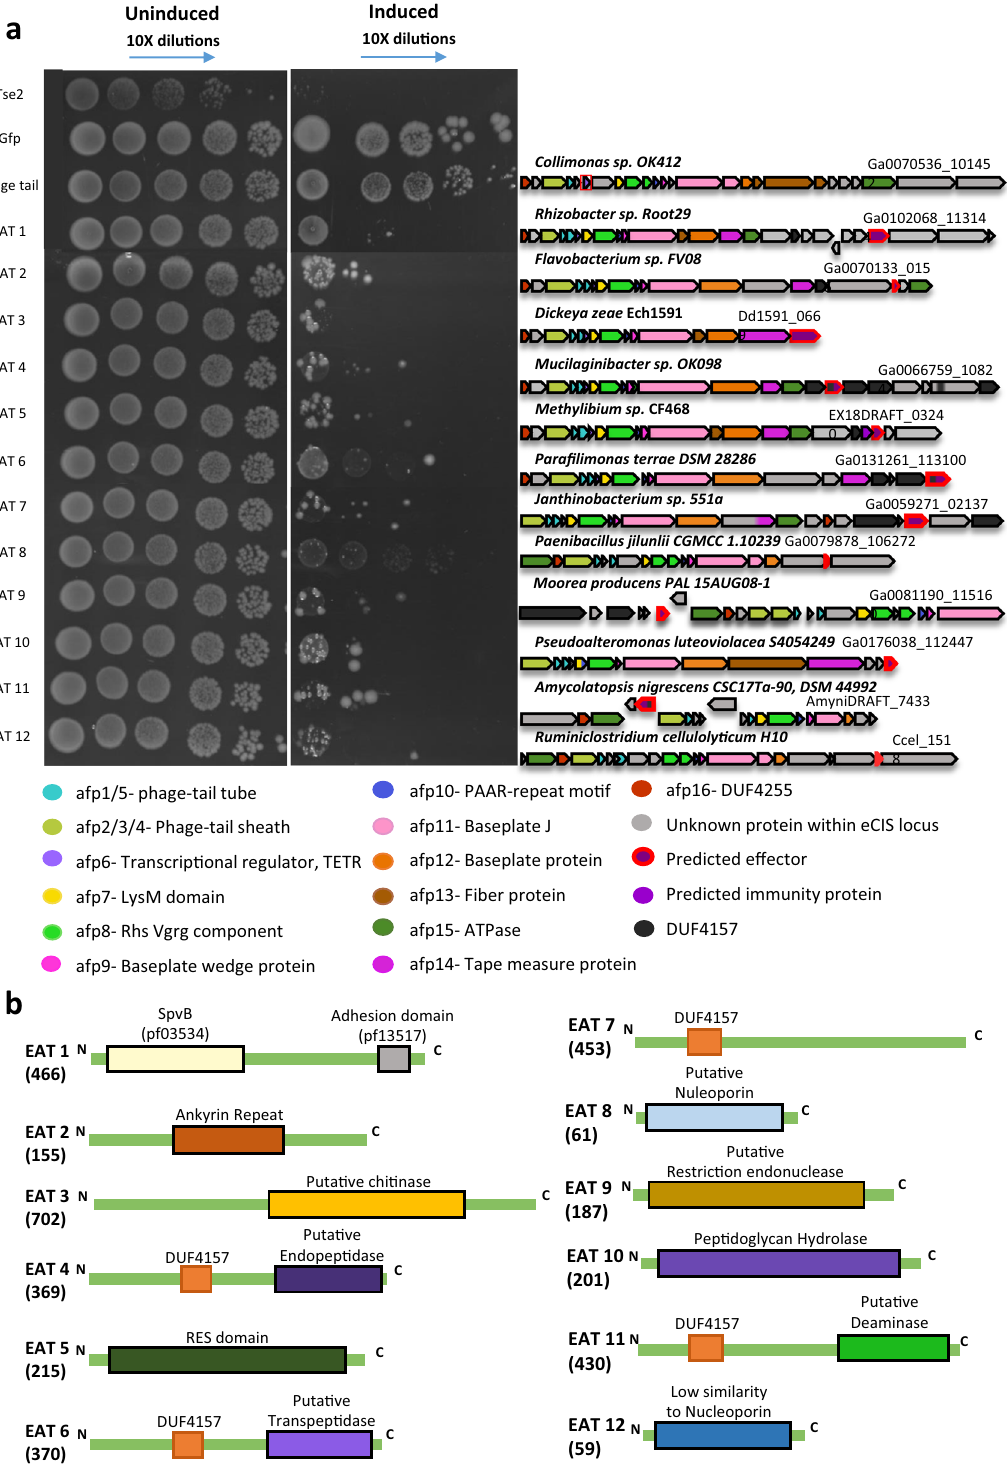
Fig. 4 EATs are toxic to E. coli . a EATs were cloned into pET28/29, transformed into E. coli , and were serially diluted and plated onto agar in induction conditions using 500 μ M IPTG (right panel) or non-inducing conditions (left panel). tse2, a known Type VI Secretion System effector, was used as a positive control. Two negative controls used were meGFP, and an eCIS gene (phage tail). On the right side of each experiment is a cartoon representing the operon of the eCIS which the EAT was cloned from (purple gene with a red border); below is a legend explaining each component ’ s color. Image shows representative results of one experiment out of two experiments with similar results. The full results are provided as a Source Data fi le. b Schematic representation of EAT protein and the domains within them. Size in amino acids is indicated in